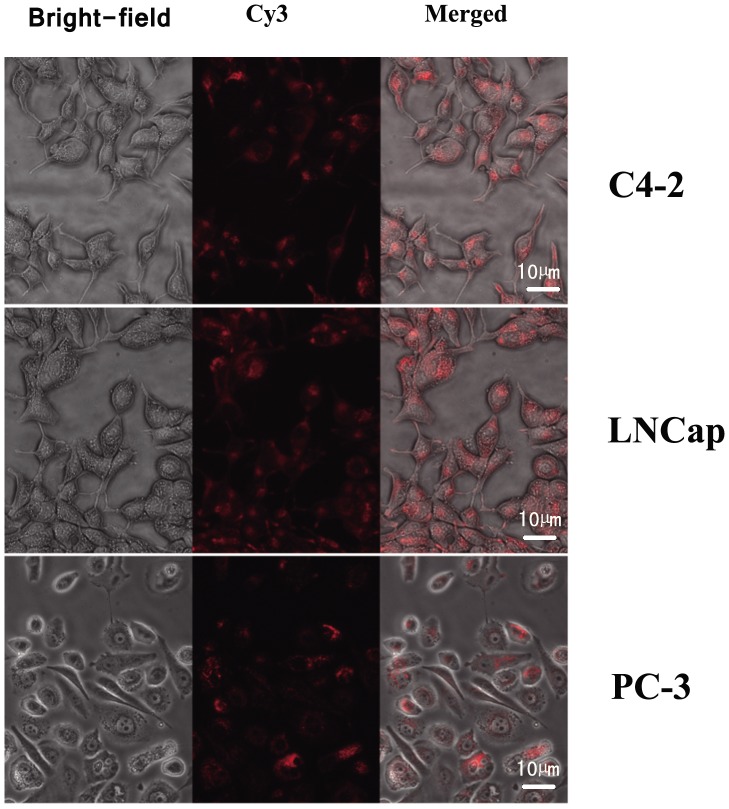
Images of three prostate cancer cell lines transfected with Cy-3-labeled AR siRNA observed using fluorescence microscopy.Red fluorescence in the cytoplasm indicates that the Cy3-labeled AR siRNA was successfully transfected (400× magnification).